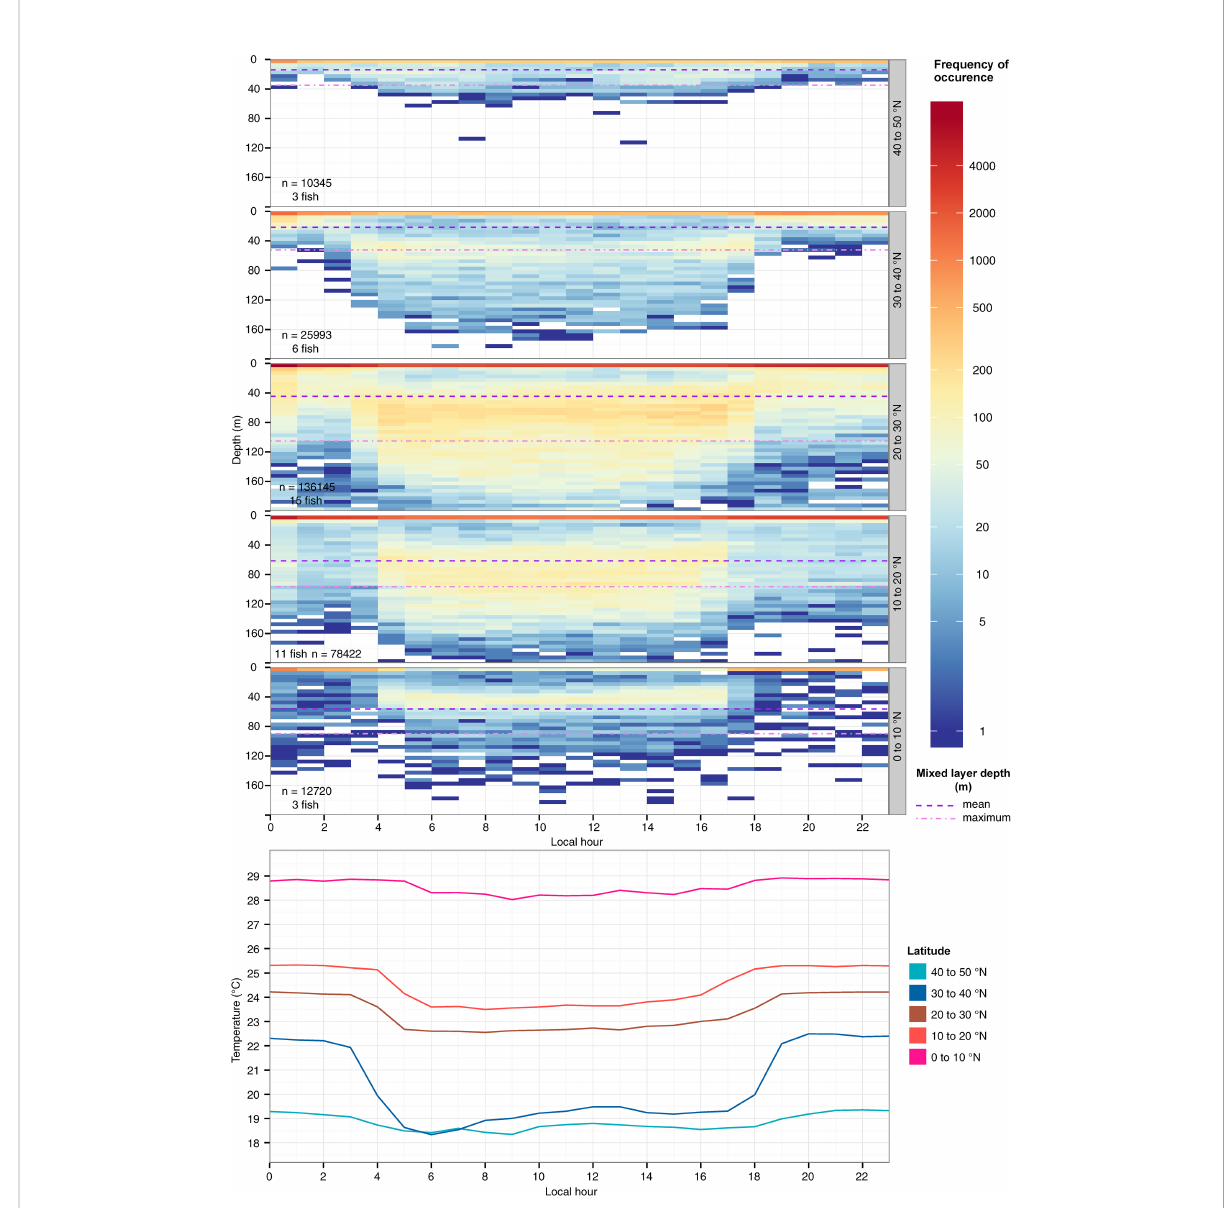
FIGURE 2 Hourly depth distribution (top) and mean temperature (bottom) of striped marlin over a 24-hour period at 10°-latitudinal bands. Colors in logarithmic scale represent frequency of occurrence (i.e., count). The number of samples and individuals contributing to the depth distribution are indicated in each panel. Mean (violet dashed line) and maximum (lavender dotted line) values for the mixed layer depth at each latitude band are shown. Depths were binned every 5 m and values deeper than 200 m were aggregated into the 200-m